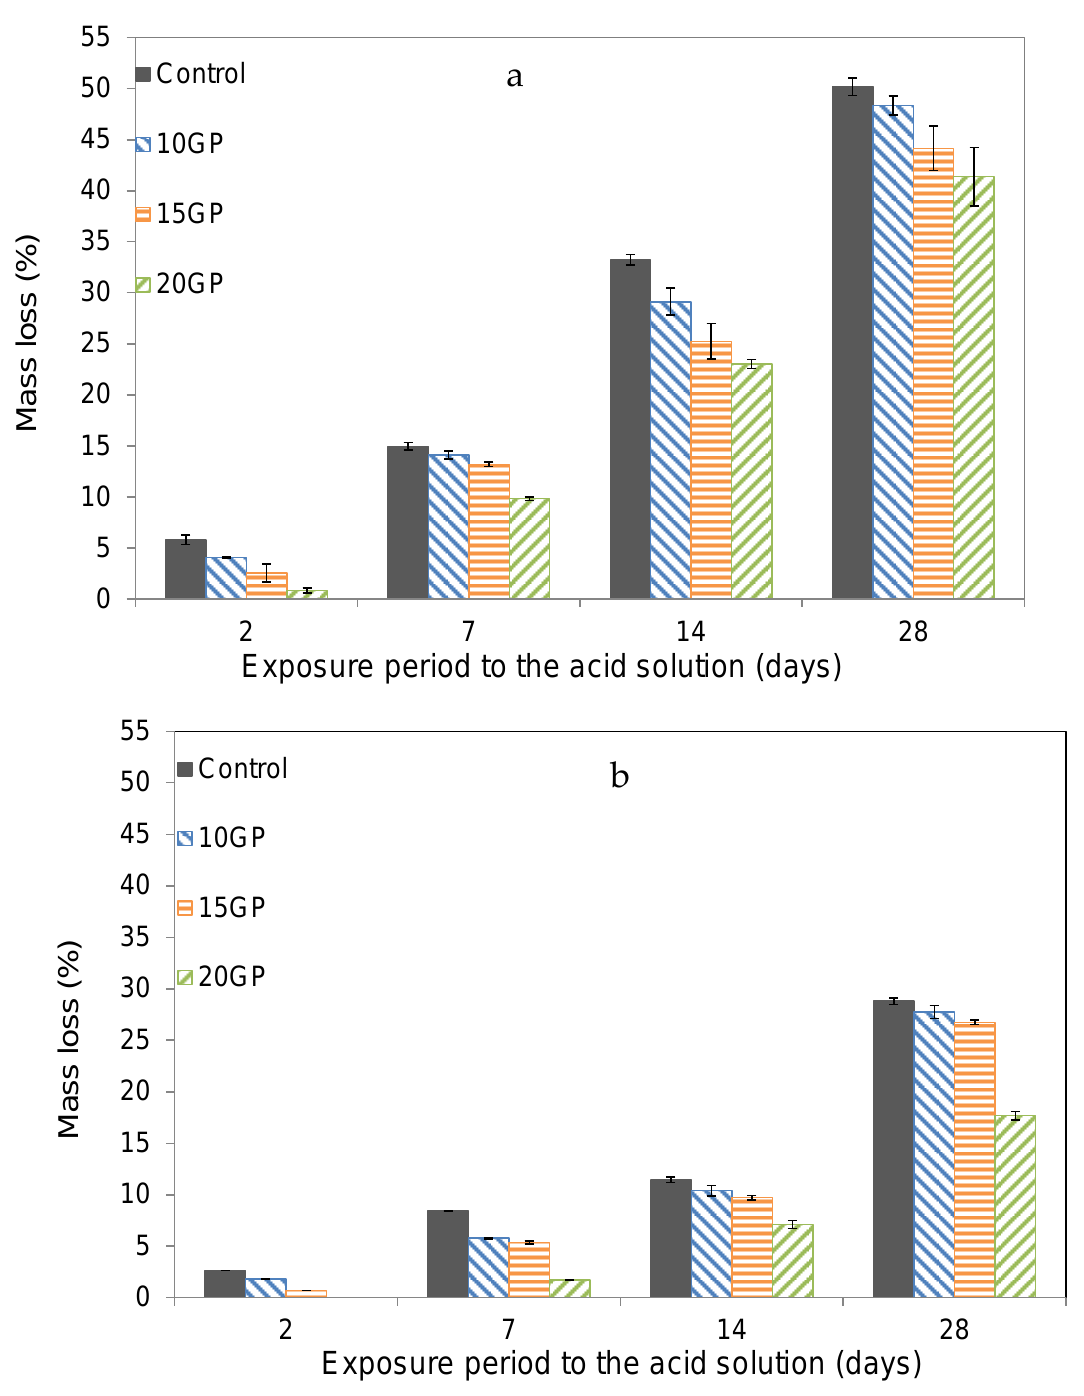
Figure 13. Mass loss of CEM I and GP mortars at 28 days ( a ) and 90 days ( b ) over the exposure time to the acid. Table 7. Di ff usion coe ffi cients of chloride ions in control and GP